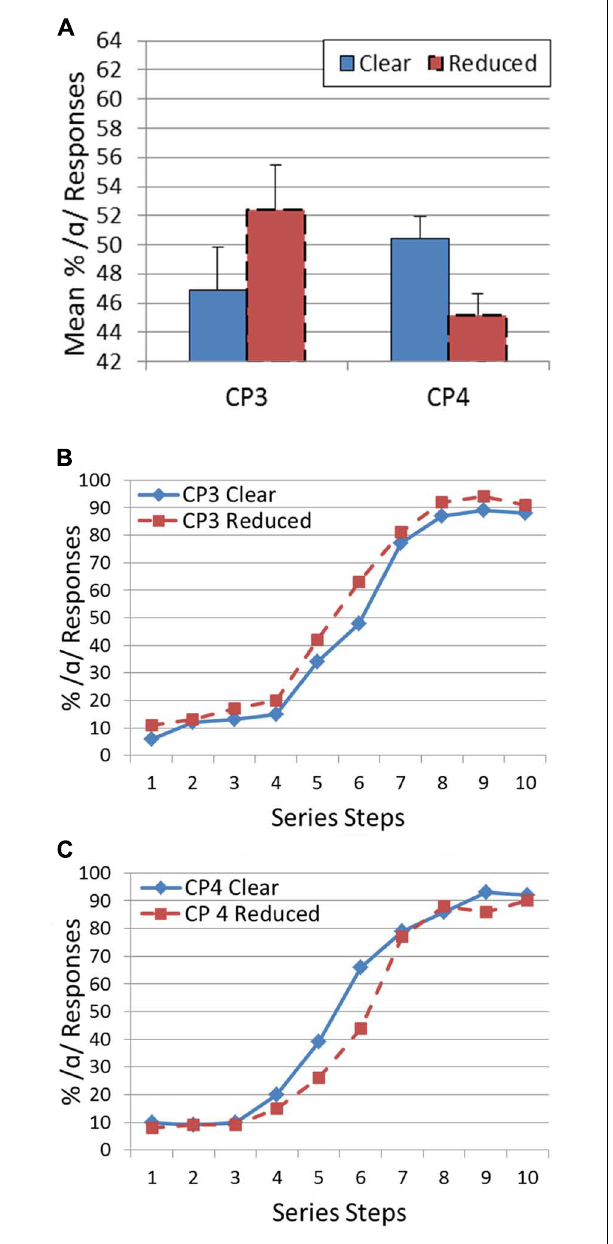
FIGURE 2 | Results of Experiment 2: (A) Histogram showing mean percentage of / α / responses for CP1 and CP2 for both a clear and reduced speaking style. Error bars indicate standard error of the mean. (B) Categorization functions showing mean percentage of / α / responses across vowel series from / (cid:2) / to / α / for CP3. Speaking style is represented by a different line. (C) Categorization functions showing mean percentage of / α / responses across vowel series from / (cid:2) / to / α / for CP4. Speaking style is represented by a different